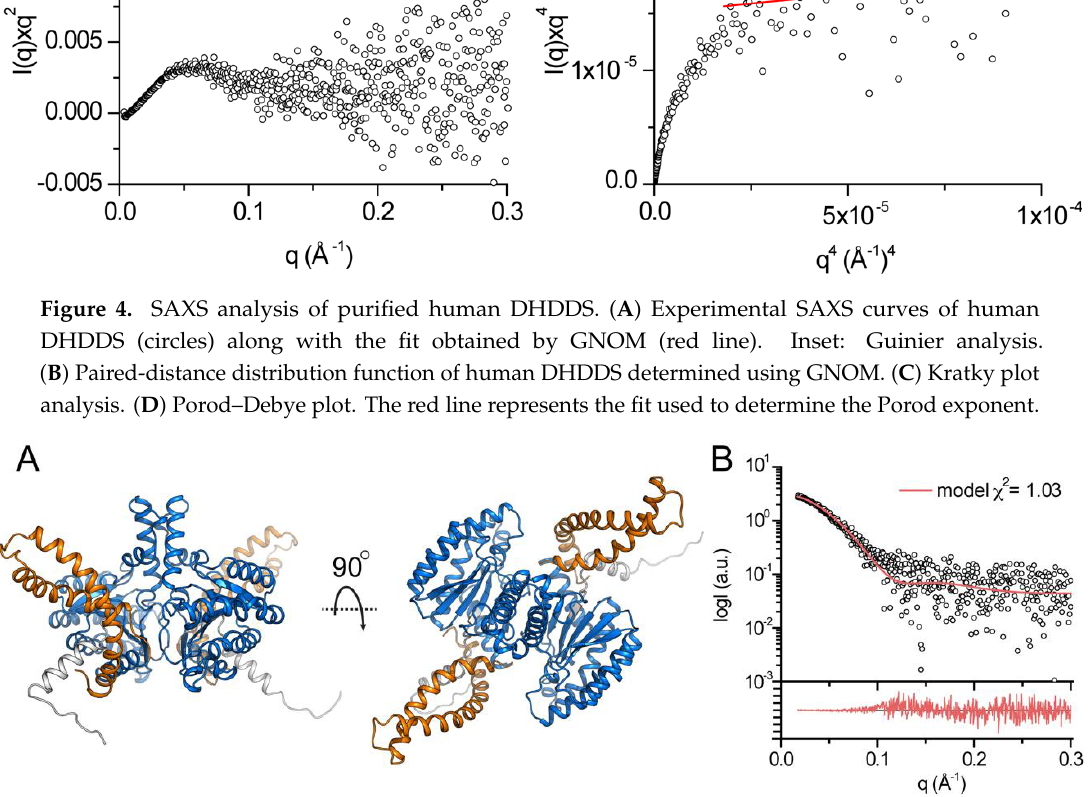
Figure 5. Computational modeling of full-length human DHDDS . ( A ) The model of full-length human DHDDS is shown in cartoon representation. The N-terminus, the cis -prenyltransferase homology domain, and the C-terminal helix – turn – helix motif are colored gray, blue, and orange, respectively.